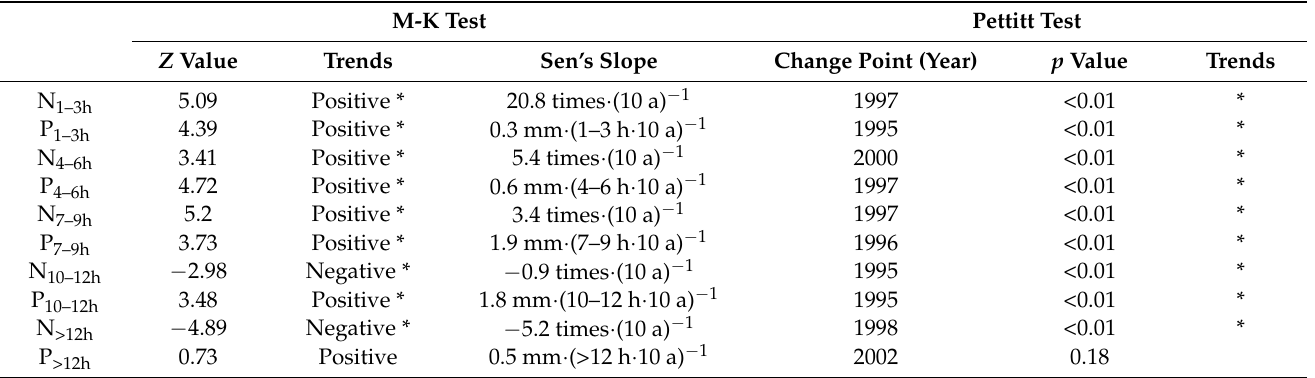
Table 5. Duration and intensity of precipitation